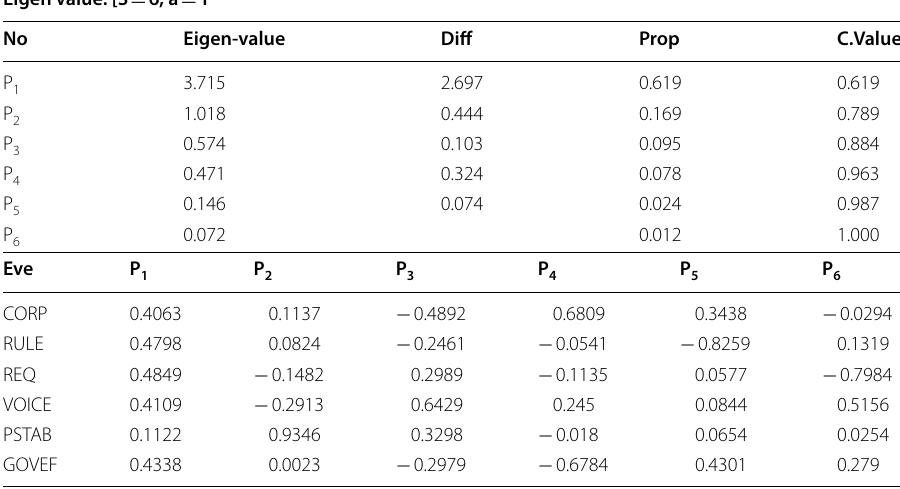
All variables are defined in Table 1